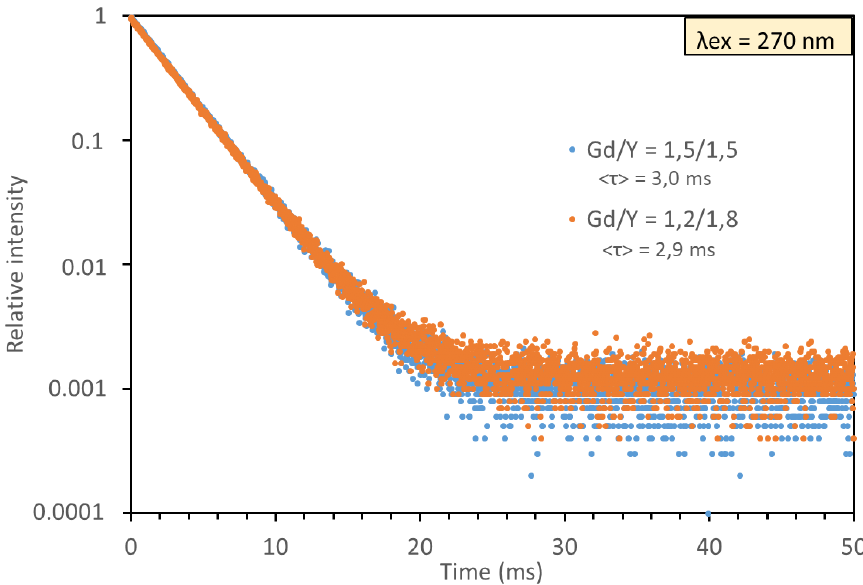
Figure 5. Room temperature PL kinetics 5 D 4 → 7 F J ( λ reg = 546 nm) in GYAGG:Tb-2 и GYAGG:Tb-3, samples. The PL intensity for sample GYAGG:Tb-2, Tb = 0.2 is approximately 20% lower than for sample GYAGG:Tb-3. Therefore, the ratio of components close to the latter composi- tion was used in the concentration series. The kinetics of scintillation at excitation by an electron-beam pulse were measured in the region of two radiative transitions 5 D 3 → 7 F J (380 nm) and 5 D 4 → 7 F J , (546 nm). Figure 6 shows scintillation kinetics measured with GAYGG:Tb, Tb = 0.15.